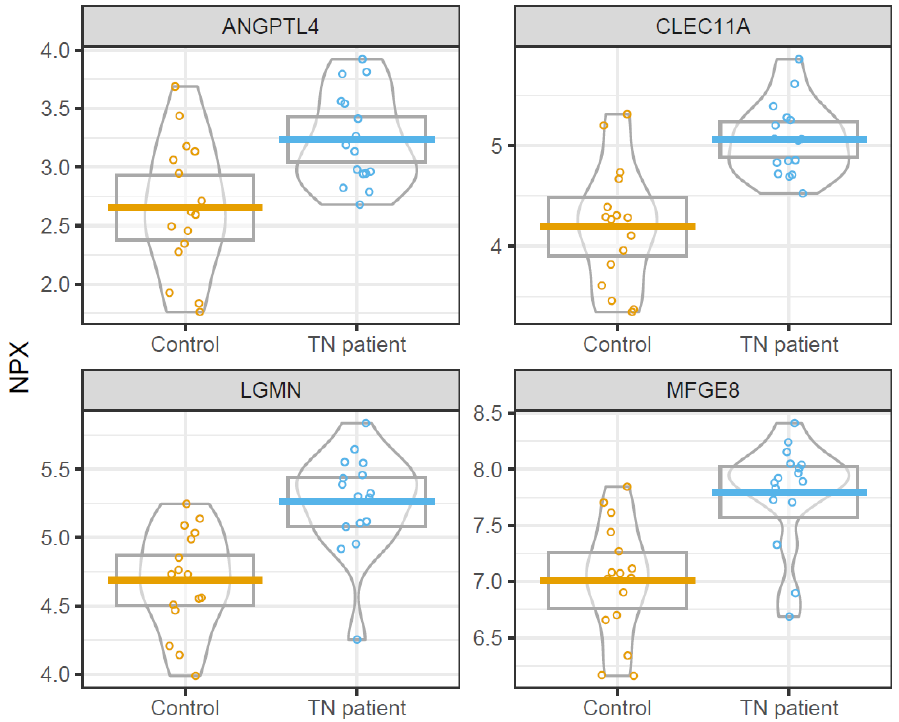
Figure 4. Elevated CSF biomarkers in TN patients. The figure demonstrates boxplots of ANGPTL-4, Clec11a, LGMN, and MFG-E8 in TN patients and controls.